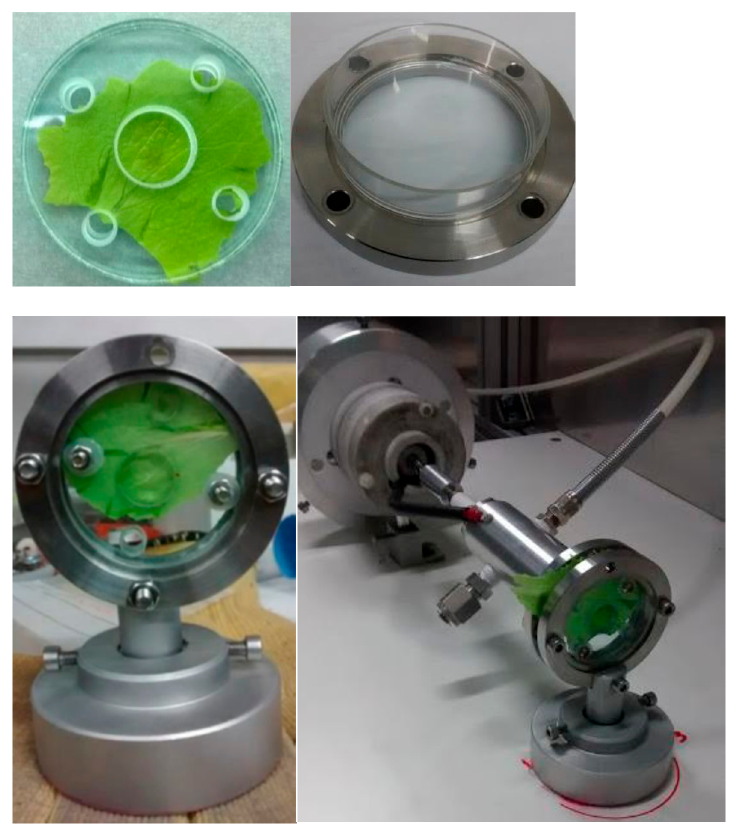
Figure 1. Experimental set